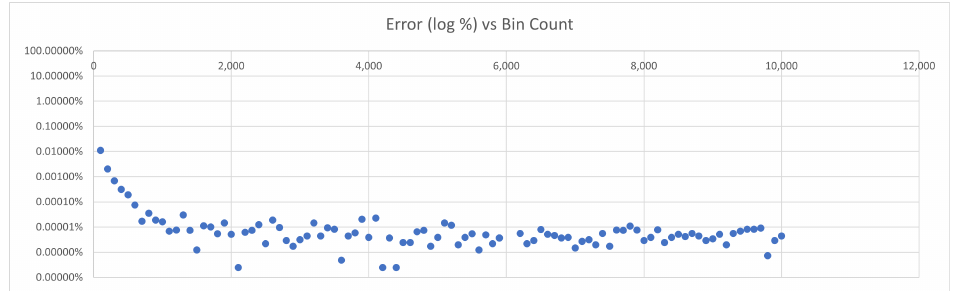
Figure 7. Log selectivity estimation error vs. the number of histogram